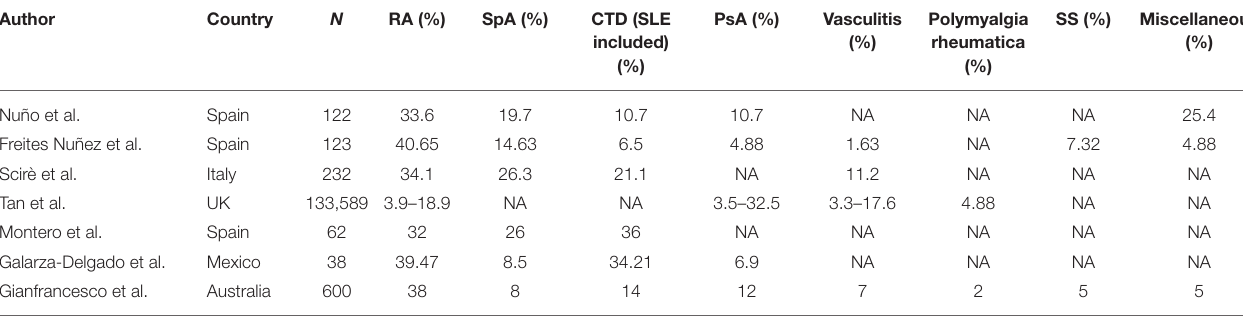
TABLE 2 | The proportion of different RADs in COVID-19 infection. Author